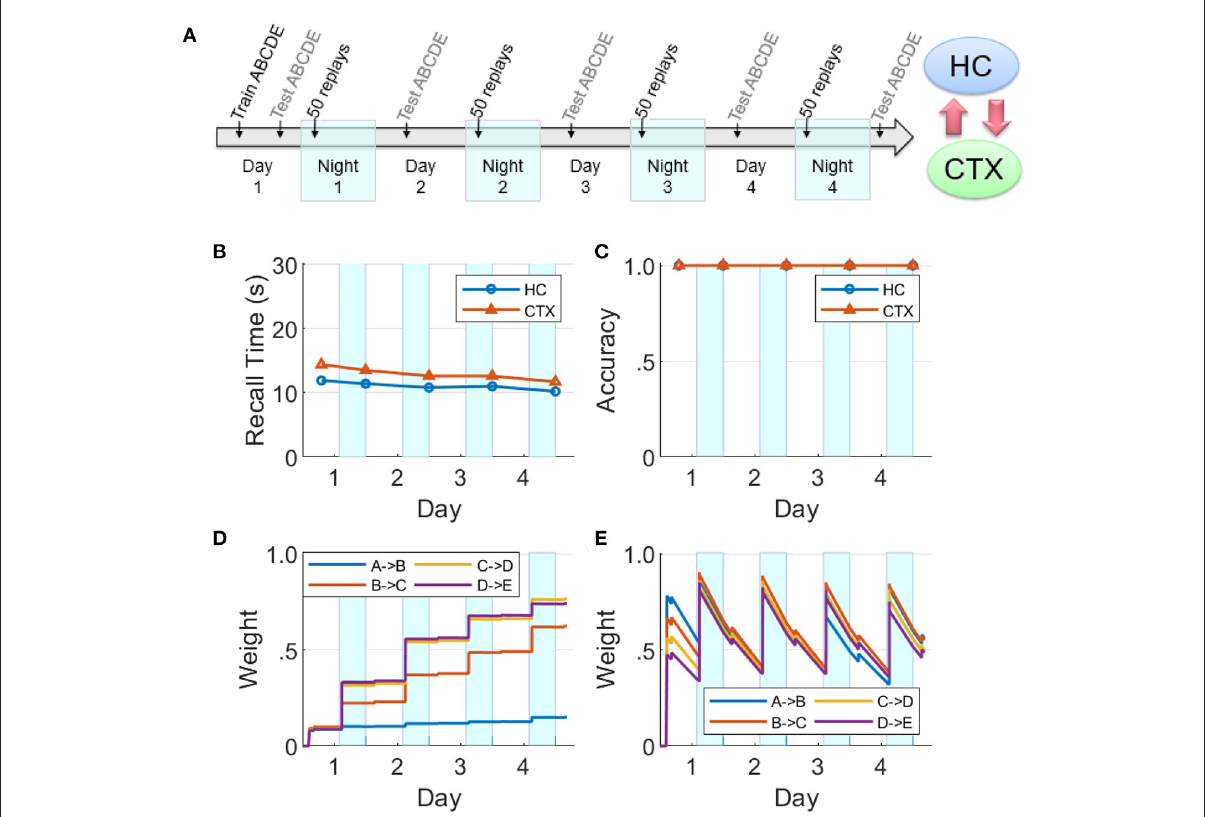
FIGURE8 Baseline network. (A) A sequence ABCDE was trained and tested on Day 1 as illustrated in the timeline. On the next four nights (highlighted with cyan patches) there were 50 non-deterministic replays biased by salience, followed by morning tests (HC, hippocampus; CTX, cortex). The middle row plots the two memory recall metrics based on each of the five waking tests: (B) Recall time, where 30 s is default for incomplete recalls. (C) Recall accuracy. The bottom row plots the dynamics of weight strengths between items of the sequence ABCDE in the cortex and hippocampus during the same period. (D) Weight strengths in CTX. (E) Weight strengths in